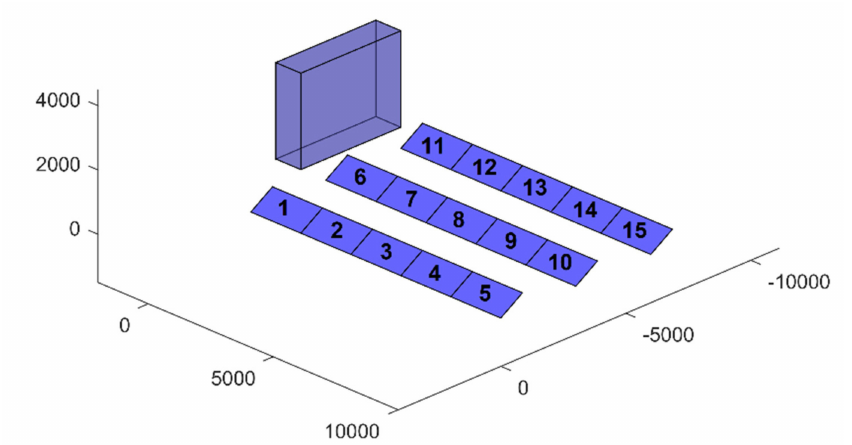
Figure 24. Proposed situation for calculating the shading tables of an array.